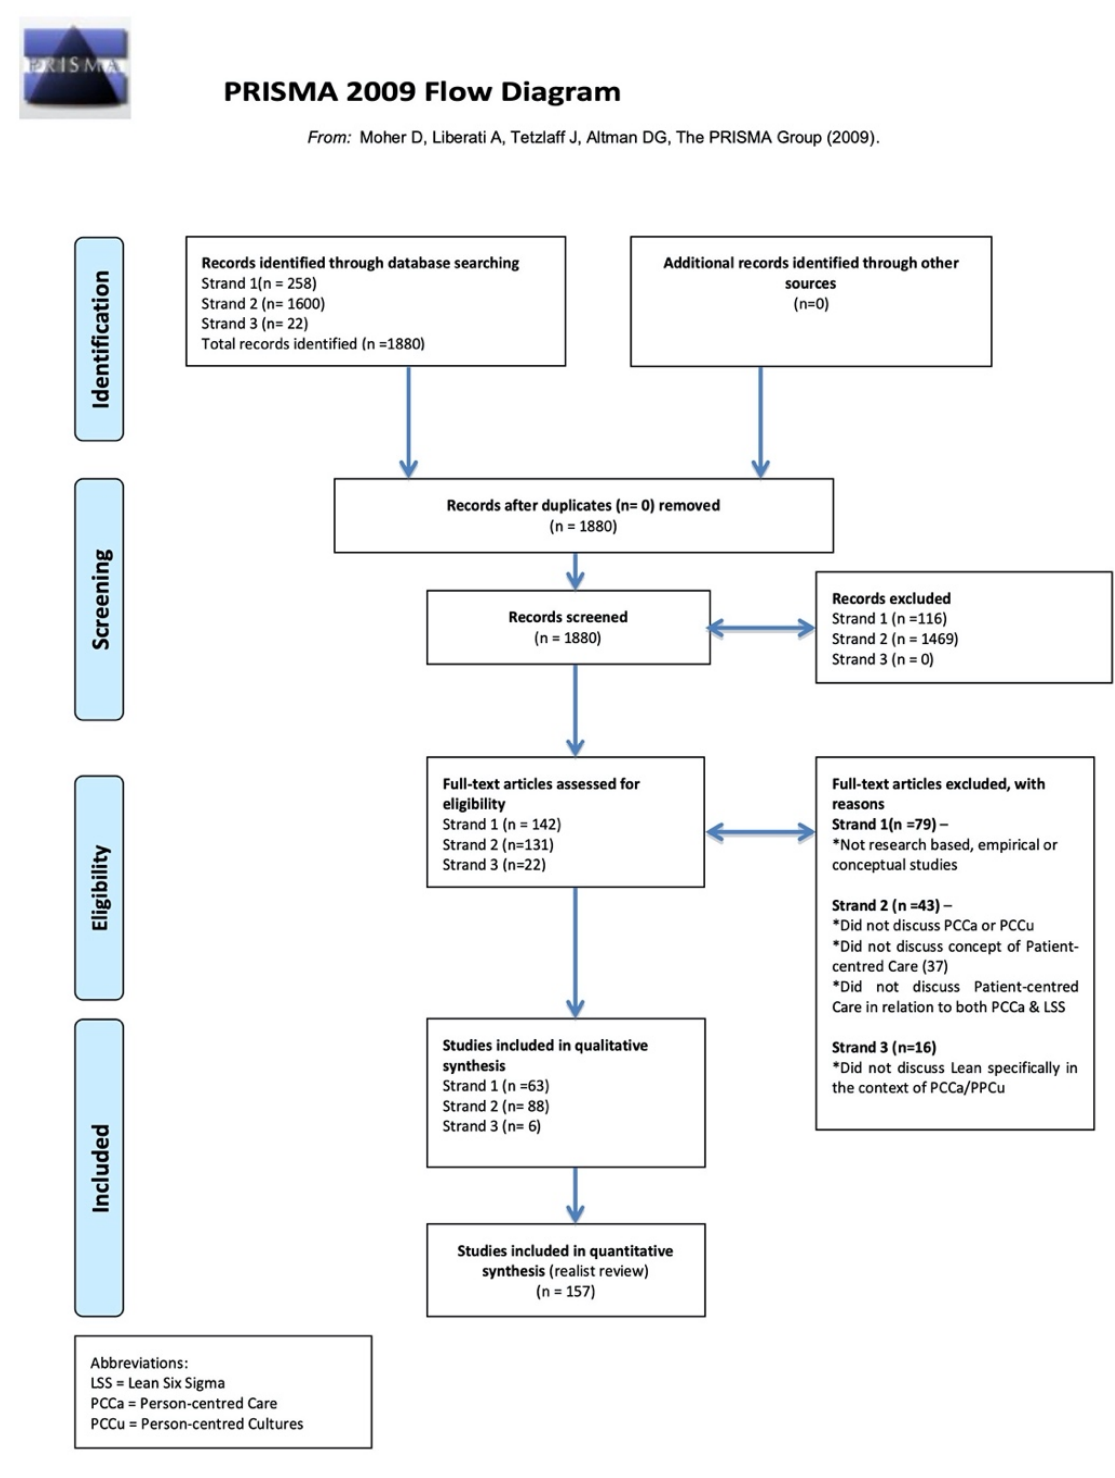
Figure 2. Modified Prisma